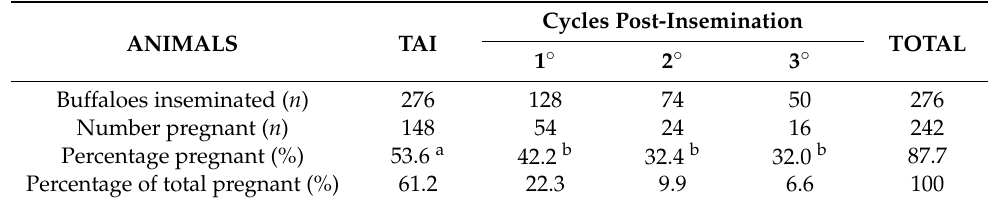
Cycles Post-Insemination